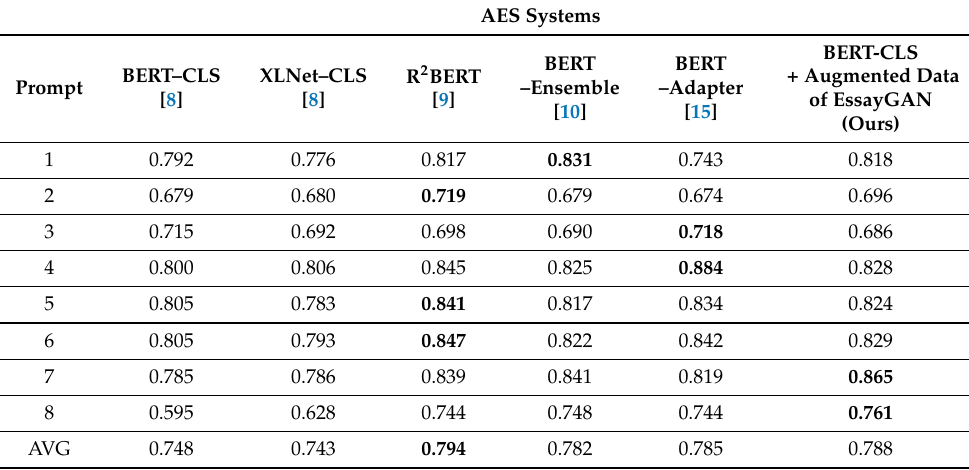
Table 7. Performance comparison with the state-of-the-art AES systems from the